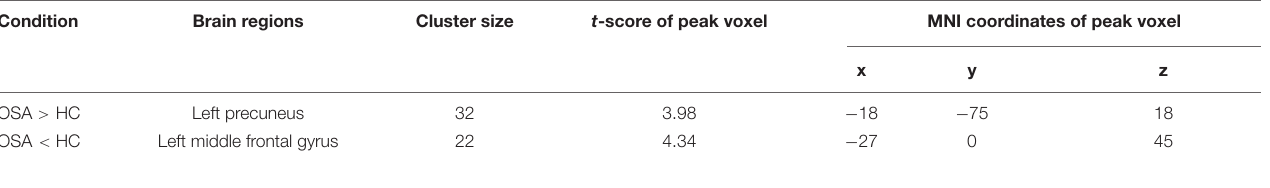
TABLE 2 | Two-sample t -tests demonstrated regions with significantly decreased ALFF in OSA children compared with controls (with GRF correction, voxel level p < 0.001, cluster level p < 0.05). Condition